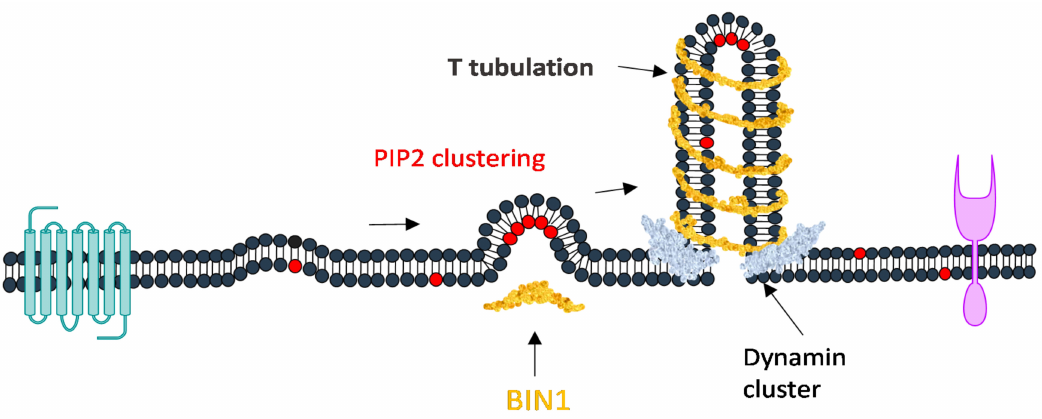
Figure 5. PIP 2 molecules are necessary to recruit MIM I-BAR, which in turn can induce local PIP 2 clustering at its two ends after binding to the membrane (upper panel). Spontaneous bending of lipid membranes can re-distribute PIP 2 molecules to the negatively curved membrane areas (lower panel), which promotes the recruitment of MIM I-BAR and maintaining the curvature [100].